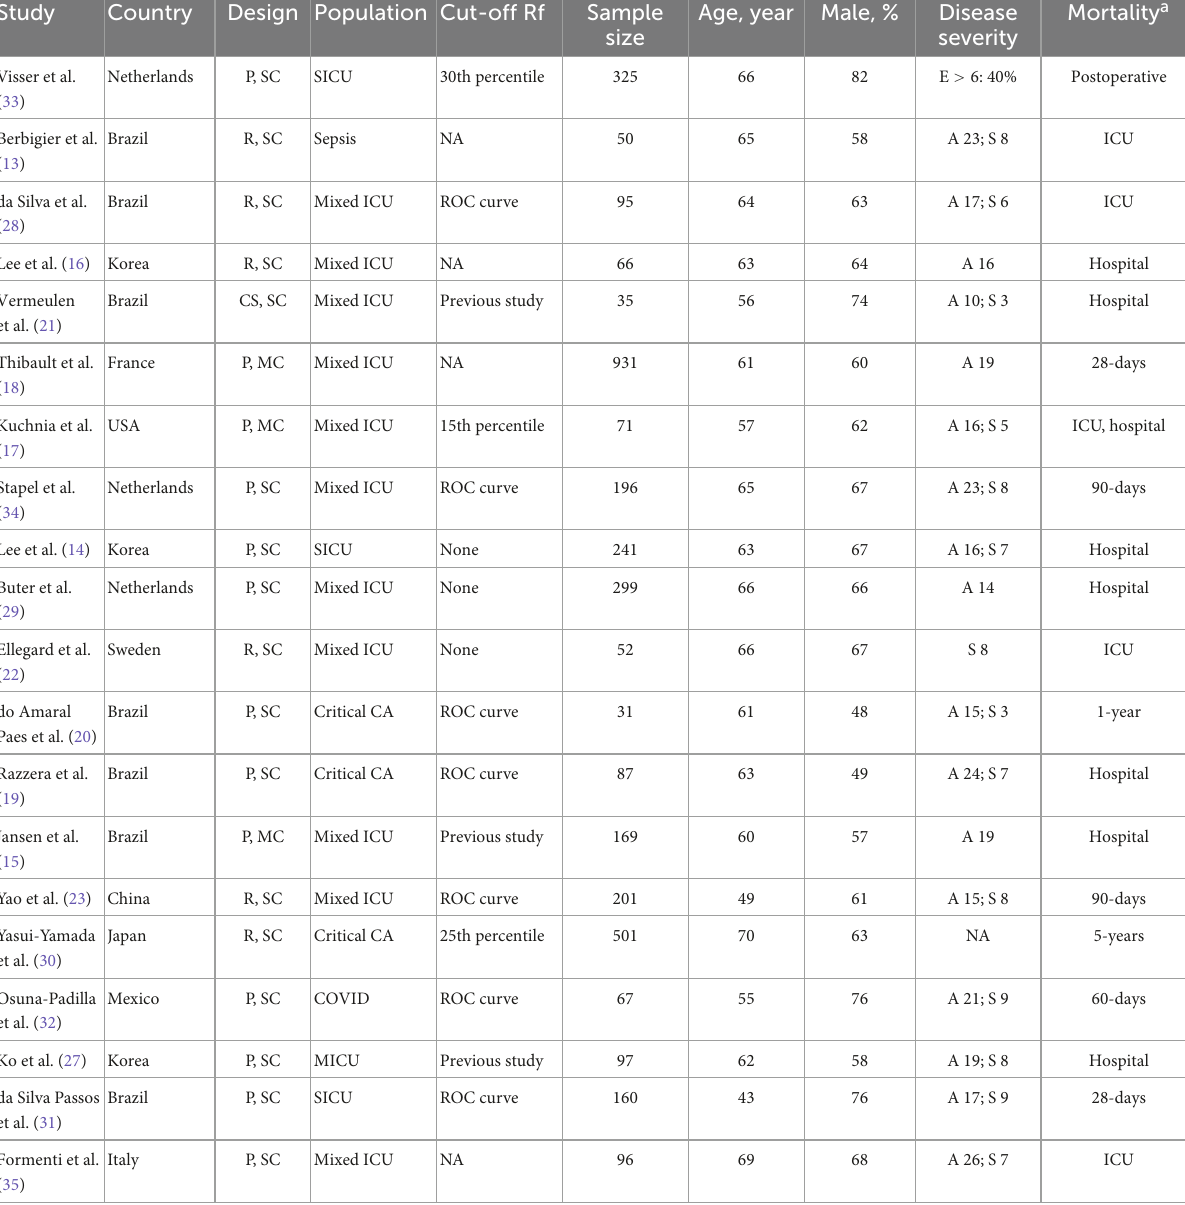
TABLE 1 Characteristics of included studies in the current